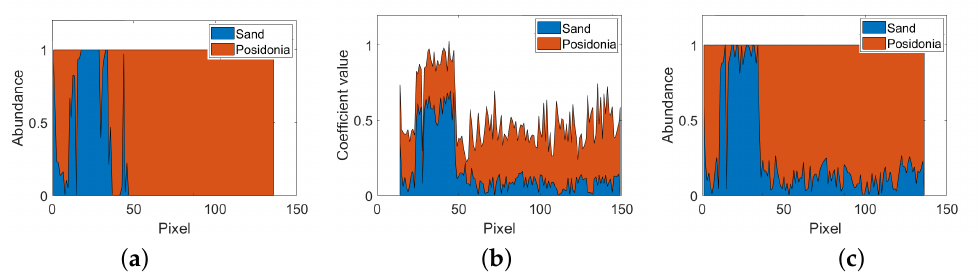
Figure 7. Part 1; ( a ) Abundances provided by the ground truth ( A GT ); ( b ) LS coefficients ( C est ); ( c ) Abundances obtained using WADJUM ( A est ).